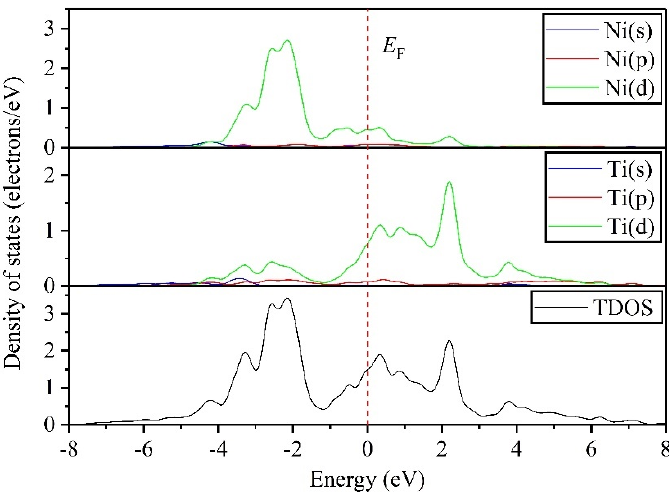
Figure 10. Partial density of states (PDOS) and total DOS (TDOS) for the NiTi SMA under 𝑃 = 0 GPa.